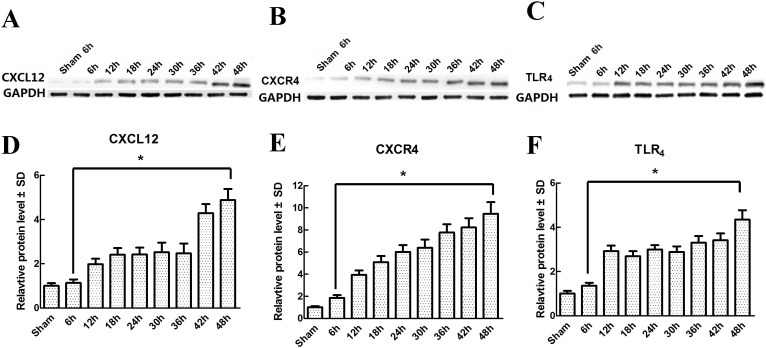
Changes in spinal CXCL12/CXCR4 and TLR4 expressions after IR-induced pain.(A-C) Representative immunoblot bands for CXCL12, CXCR4 and TLR4. GAPDH served as an internal standard. (D-F) Relative protein levels of CXCL12, CXCR4 and TLR4 were calculated as fold increases vs. the sham group. Data are expressed as the mean ± SD. *P < 0.05 vs. the sham group.